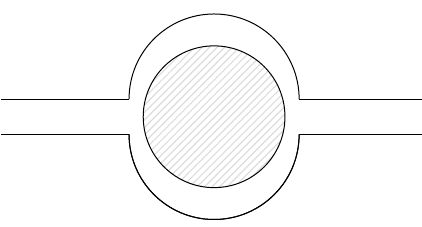
Figure 18. Planar connected diagram with 2 external legs: here, as well as in all subsequent diagrams, a shaded blob represents a planar connected